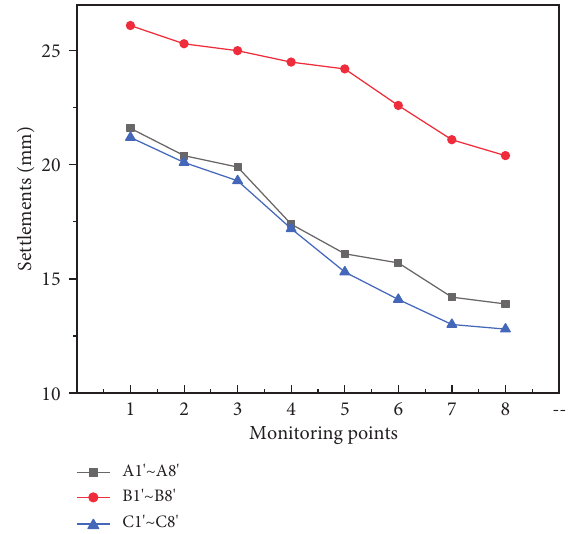
Figure 16: Tunnel vault settlement